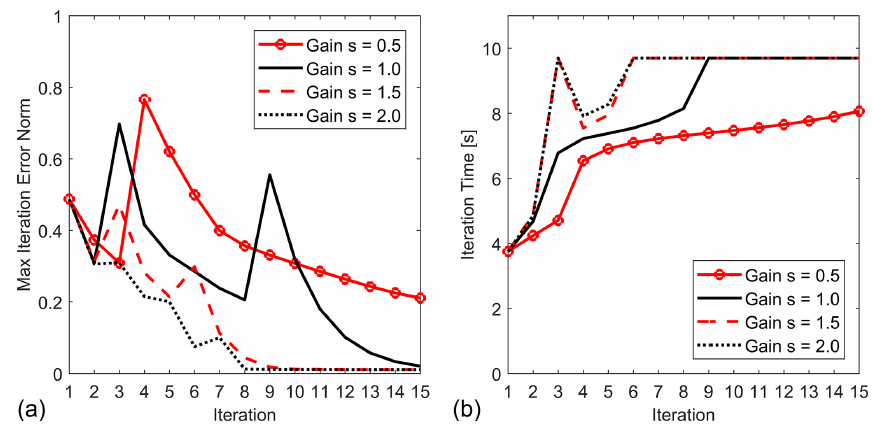
Figure 5. Convergence comparison of the ILC process for Trajectory A for different values of the multiplier gain s and fine-tuning gain p = 0: (a) maximum tracking error and (b) iteration times.